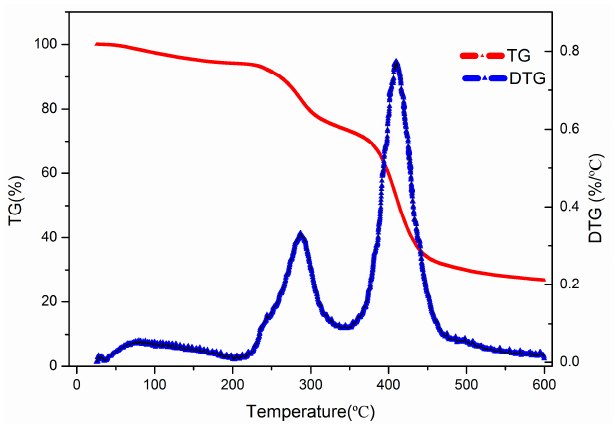
Figure 4. TG and DTG curves of PASD.